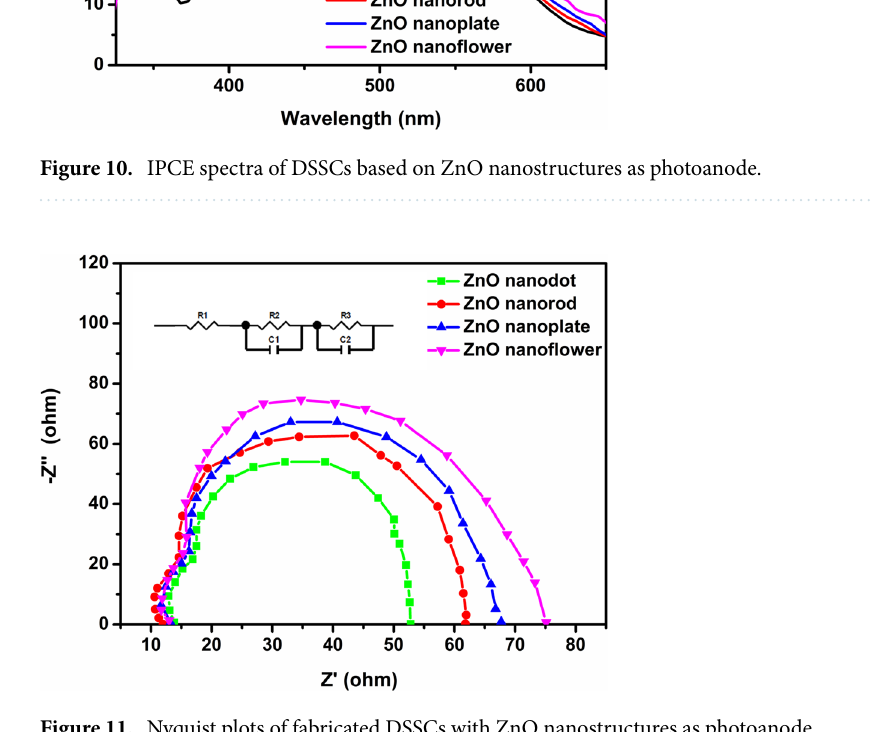
Figure 11. Nyquist plots of fabricated DSSCs with ZnO nanostructures as